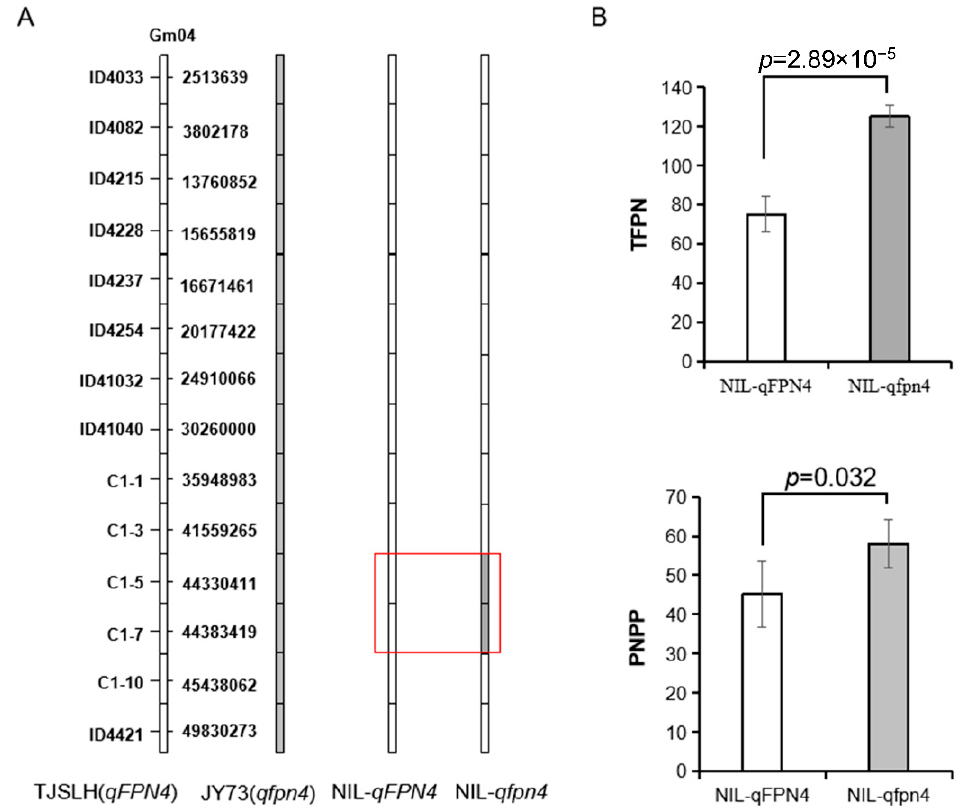
Figure 4. Development of NILs for qFPN4 and phenotypes comparison. ( A ) The genotype of NIL- qFPN4 and NIL- qfpn4 on chromosome 4; ( B ) TFPN and PNPP between NIL- qFPN4 and NIL- qfpn4 .